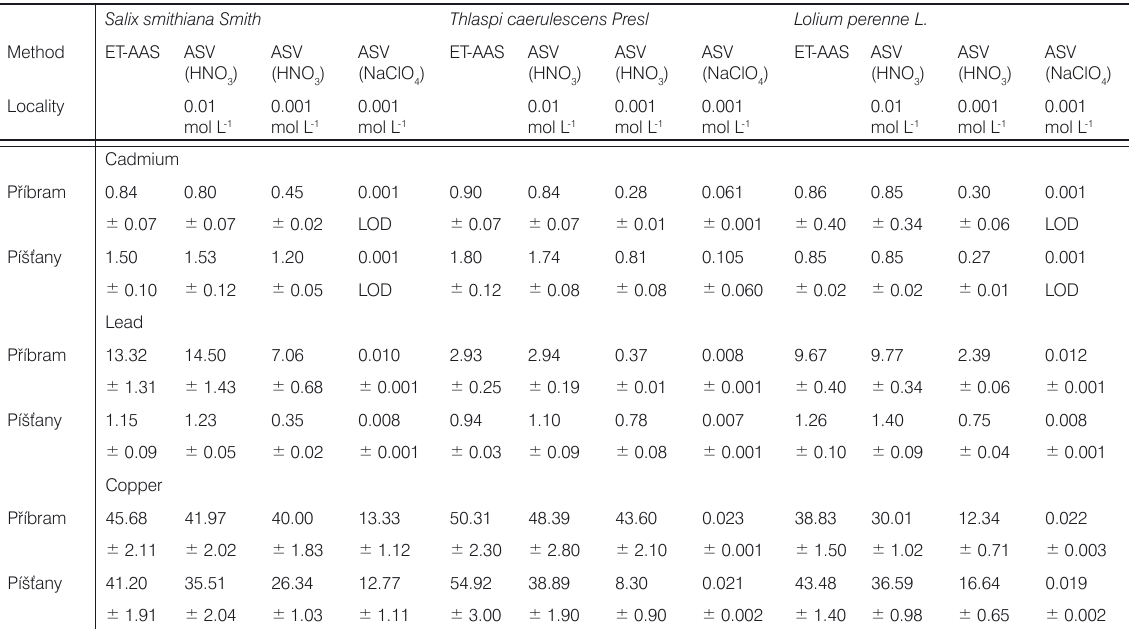
) and HM ionic contents 3